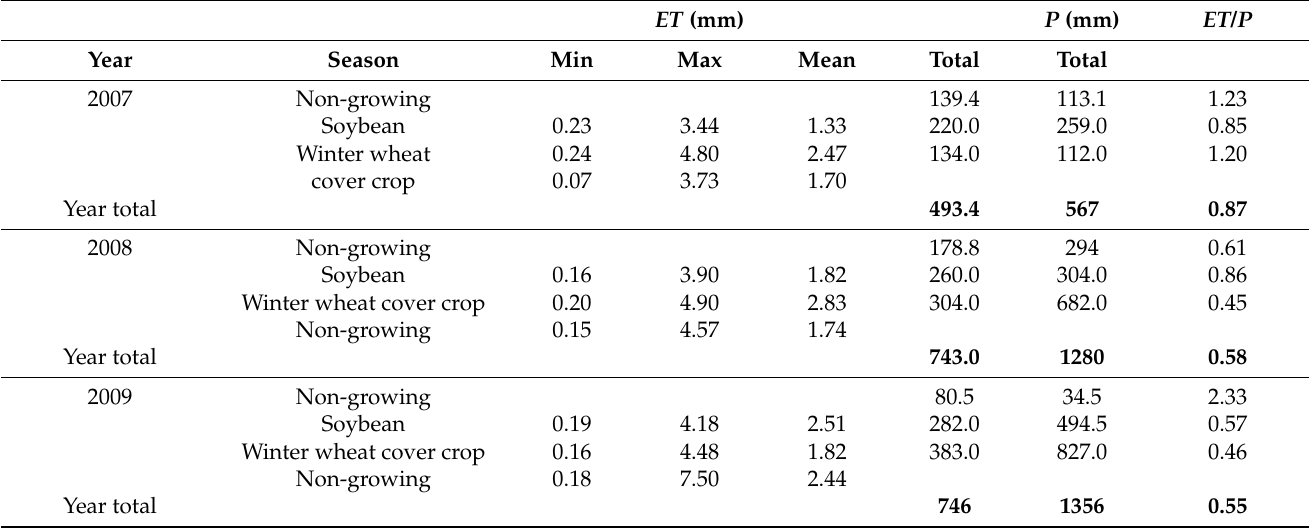
Figure 4. Ten-day binned average course of albedo for DOY 121–240 between 9:00 AM to 16:00 PM (LST) hours during 2007 (black circle, filled), 2008 (white circle), and 2009 (filled inverted triangle) mornings and in late afternoons. The midday average 0.16 of albedo for winter wheat cover crop were lower (range 0.10–0.22) than for soybean (0.17). Table 3. Seasonal (growing and non-growing) minimum, average, and maximum values of mea- sured ET (mm), precipitation (mm), and ET/P ratio (evaporative fraction) at WTARS for the period